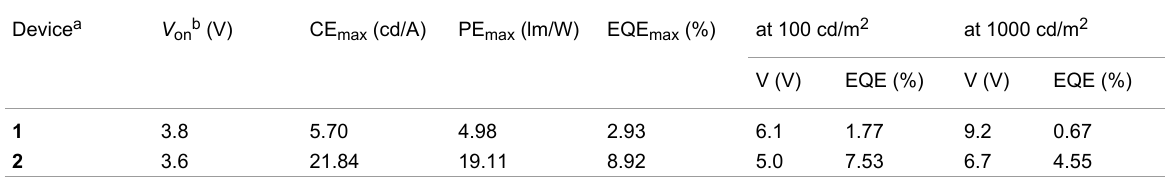
Table 5: Summary of the device performances of the OLEDs based on 1 and 2 .